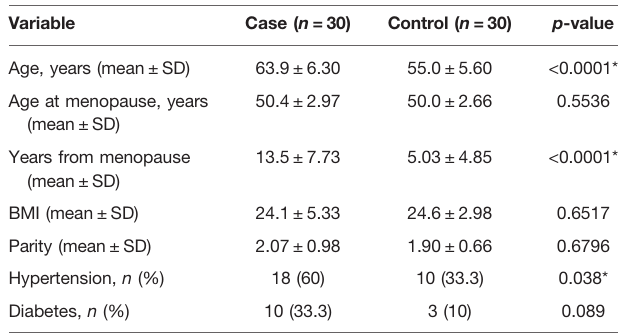
TABLE 1 | Clinical characteristics of the study population.